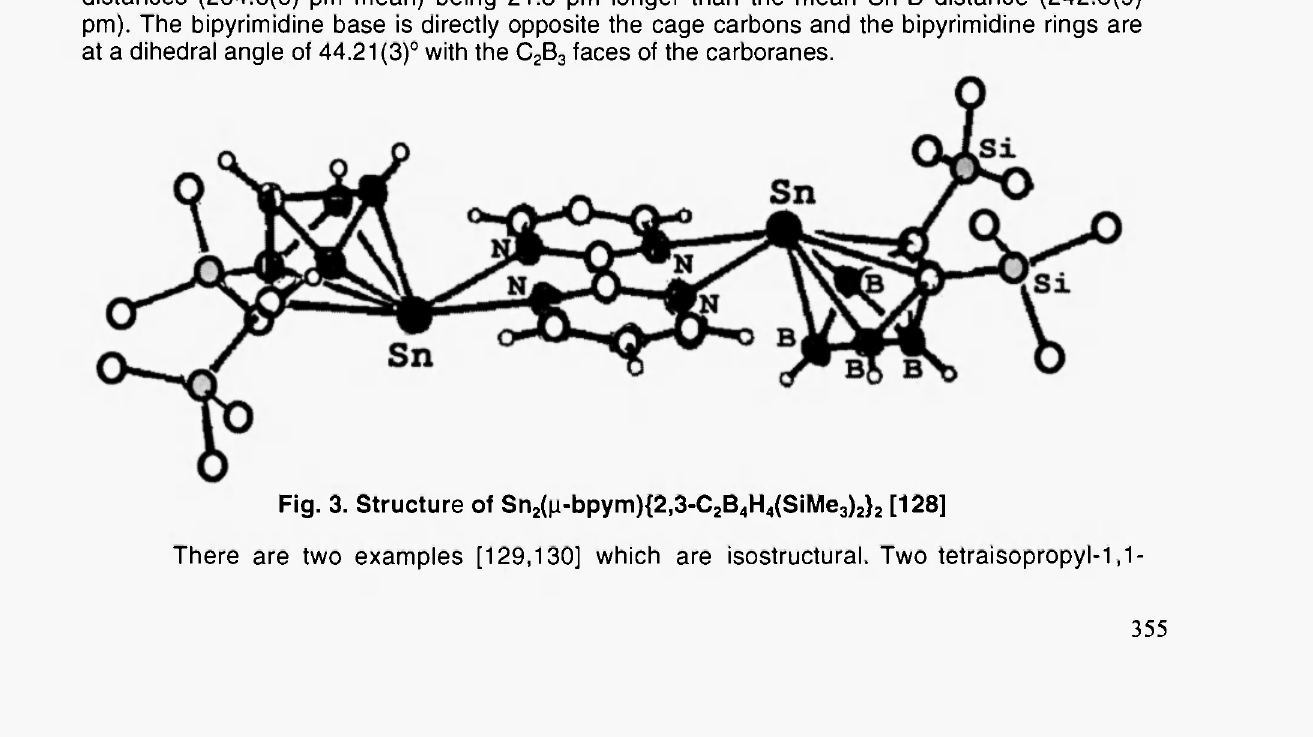
Fig. 3. Structure of Sn 2 ^-bpym){2,3-C 2 B 4 H 4 (SiMe 3 ) 2 }